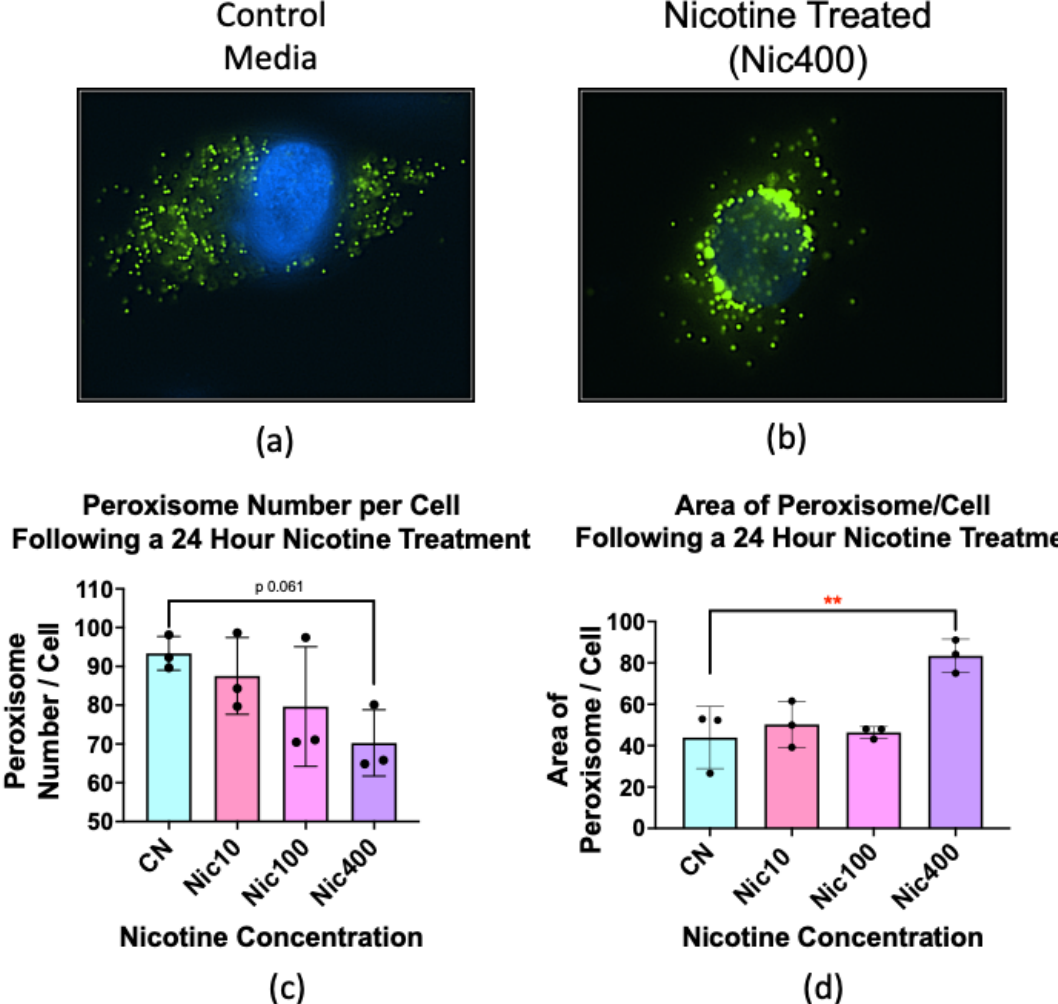
Figure 6. Peroxisome morphology in keratinocytes after nicotine treatment. ( a , b ) Micrographs of peroxisomes (green) in keratinocytes following treatment with ( a ) control medium and ( b ) Nic 400. ( c ) Number of peroxisomes per cell following treatment with control medium, Nic10, Nic100, and Nic400 for 24 h; ( d ) area of peroxisomes per cell following treatment with control medium, Nic10, Nic100, and Nic400 for 24 h. CN = control medium. All data are means ± the standard error of the mean for three independent experiments. ** = p < 0.01.